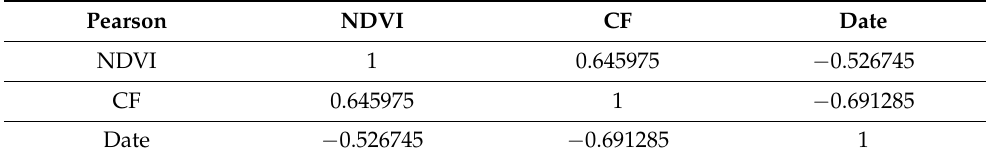
Table 2. Pearson correlation